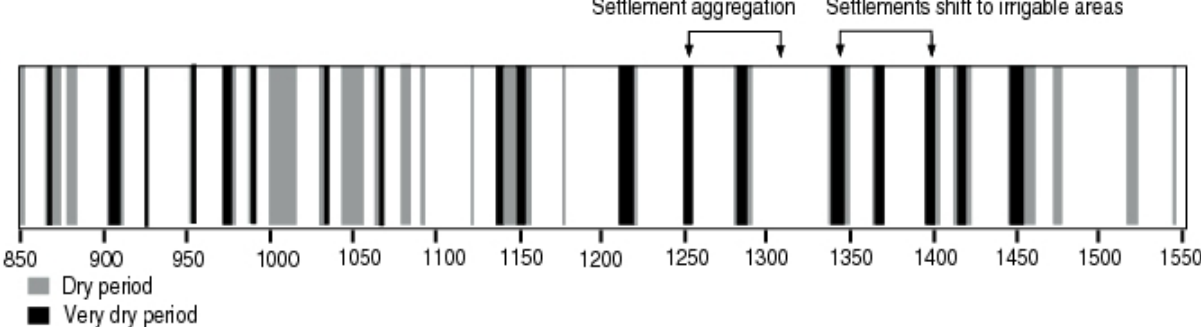
Fig. 6. Periods of extremely low precipitation in Zuni region. Periods of extremely low precipitation were identified by Ingram ( unpublished manuscript ) using a nine-year interval running average throughout the duration of the tree-ring precipitation reconstruction (i.e., AD 622–1994). Extreme lows were defined as those intervals in the lowest quartile and decile of the distribution of all nine-year intervals in the